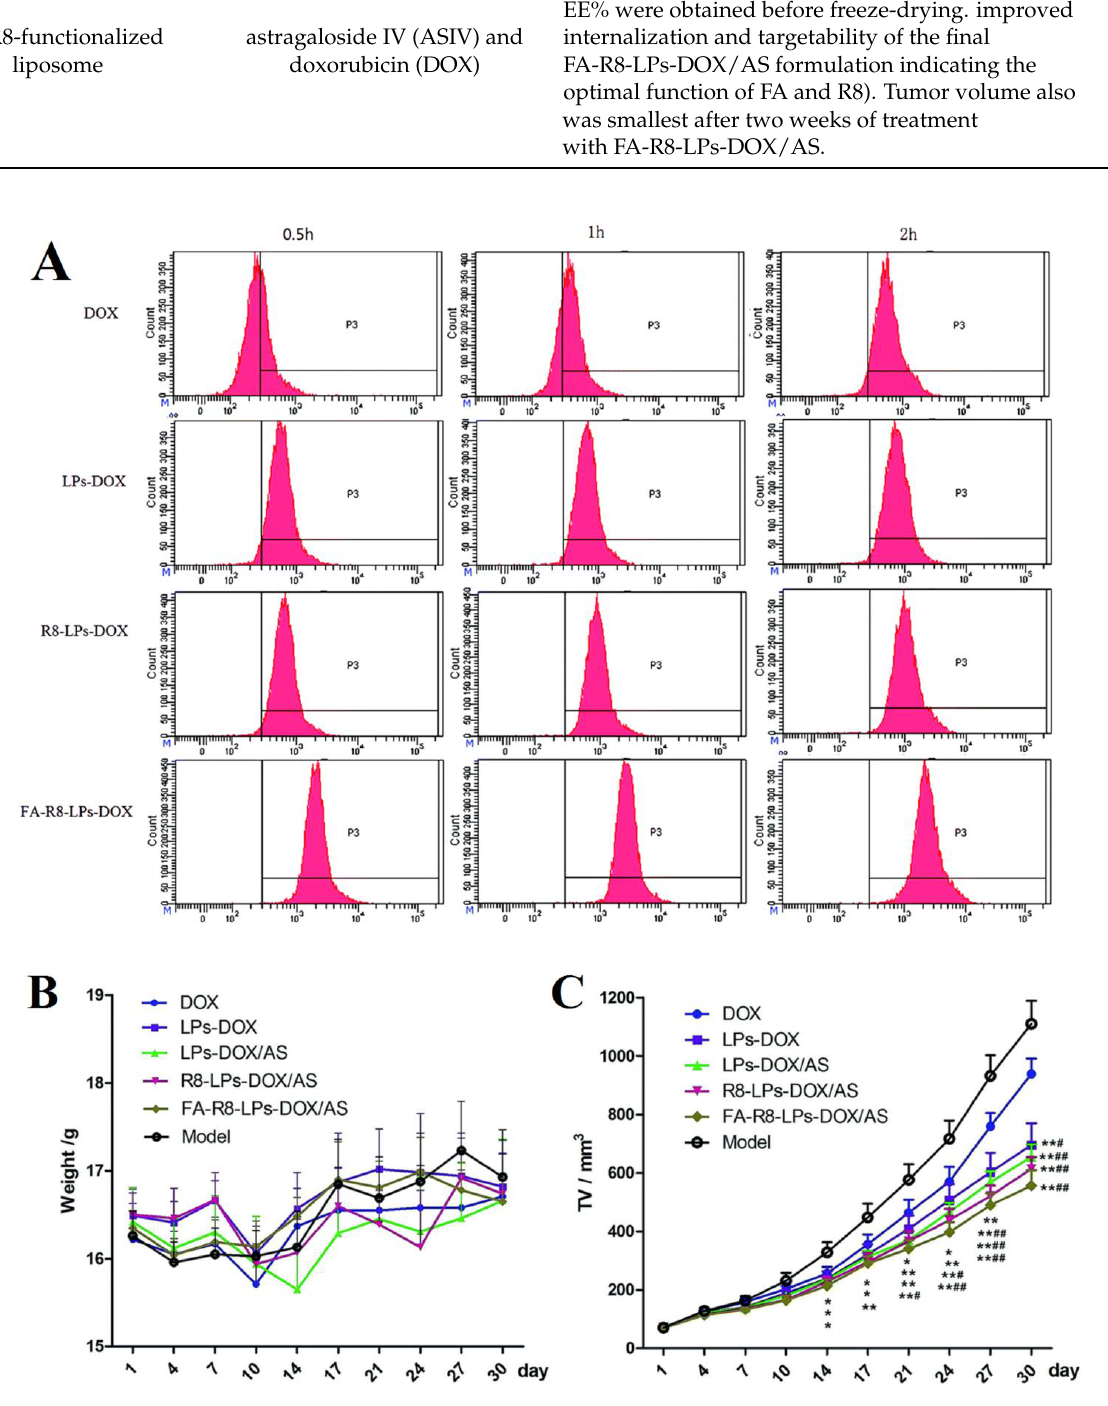
Figure 7. ( A ) Flow cytometry diagrams in different time intervals. ( B ) Changes in body weight in mice treated in different test groups. ( C ) Changes in tumor volume treated in different test groups (in comparison to control group with * p < 0.05 and ** p < 0.01 and DOX group with # p < 0.05 and ## p < 0.01). Reproduced from Yue et al. [150]. © The Royal Society of Chemistry